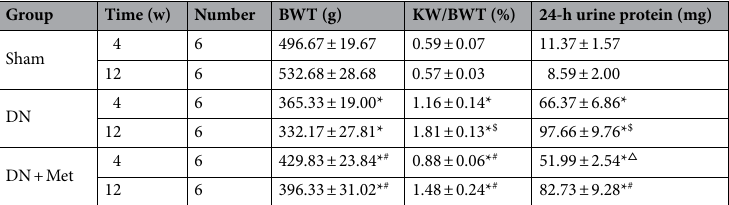
Table 2. Comparison between BWT, KW/BWT, and 24-h urine protein in each group ( n = 6). All data were shown as mean ± SD ( n = 3). BWT: body weight; KW: kidney weight; Sham: control group; DN: diabetic nephropathy group; Met: metformin. * P < 0.01 vs. Sham group by ANOVA, #, △ P < 0.01 vs. DN group by ANOVA, $ P < 0.05 vs. 4-week DN/DN + Met group by